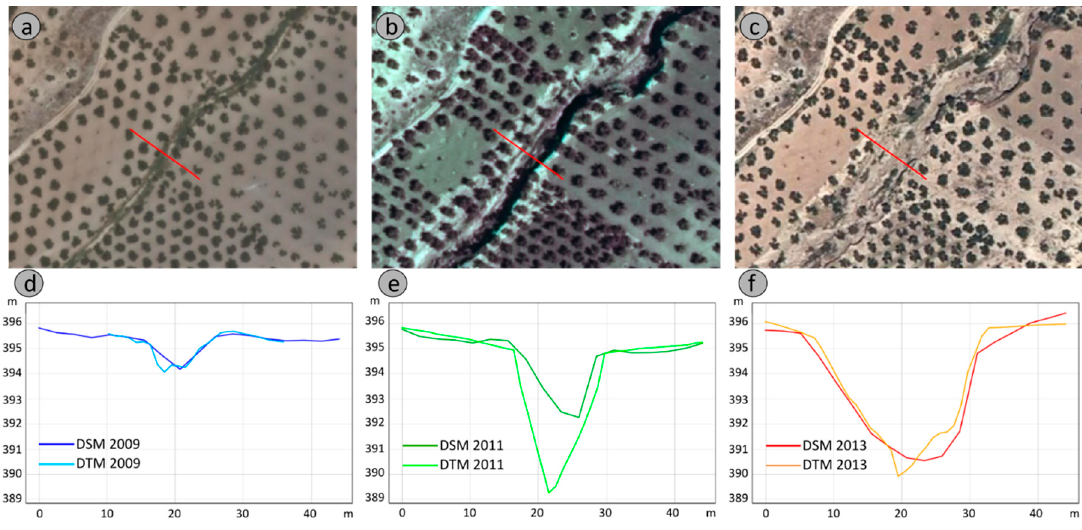
Figure 10. Orthophotographs and DSMs/DTMs sections: ( a ) orthophotograph of 2009; ( b ) orthophotograph of 2011; ( c ) orthophotograph of 2013; ( d ) sections of 2009; ( e ) sections of 2011; ( f ) sections of 2013.